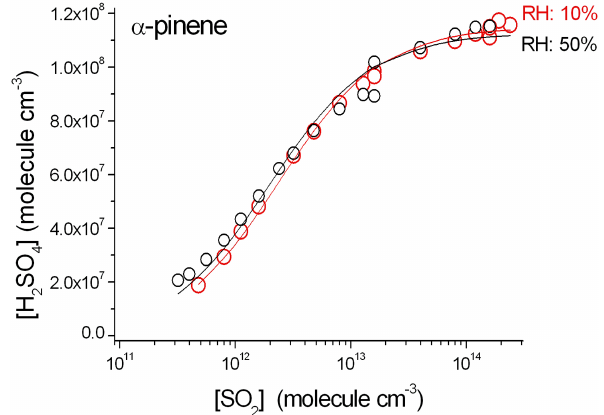
Figure 3. Loss-corrected measured [H 2 SO 4 ] at the outflow of IfT- LFT in α -pinene experiments at RH = 10% and RH = 50%. Solid lines show multivariate least-squares fittings according to Eq. (3). Dashed line shows the multivariate least-squares fittings according to Eq. (5), which accounts for the different behaviour of different